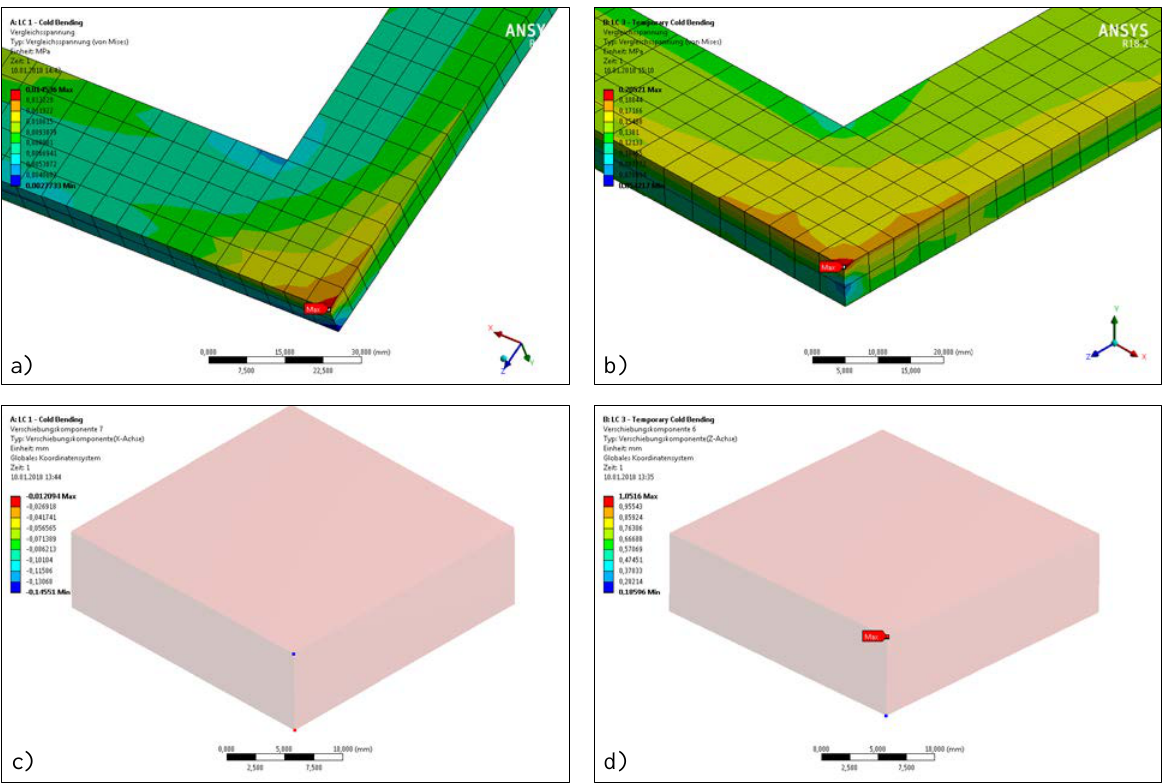
Fig. 12 Comparison between permanent cold bending (LC 1) and temporary state during installation (LC 3): equivalent stresses - a) LC 1 and b) LC 3, different shear deformation - c) LC 1 and d) LC 3